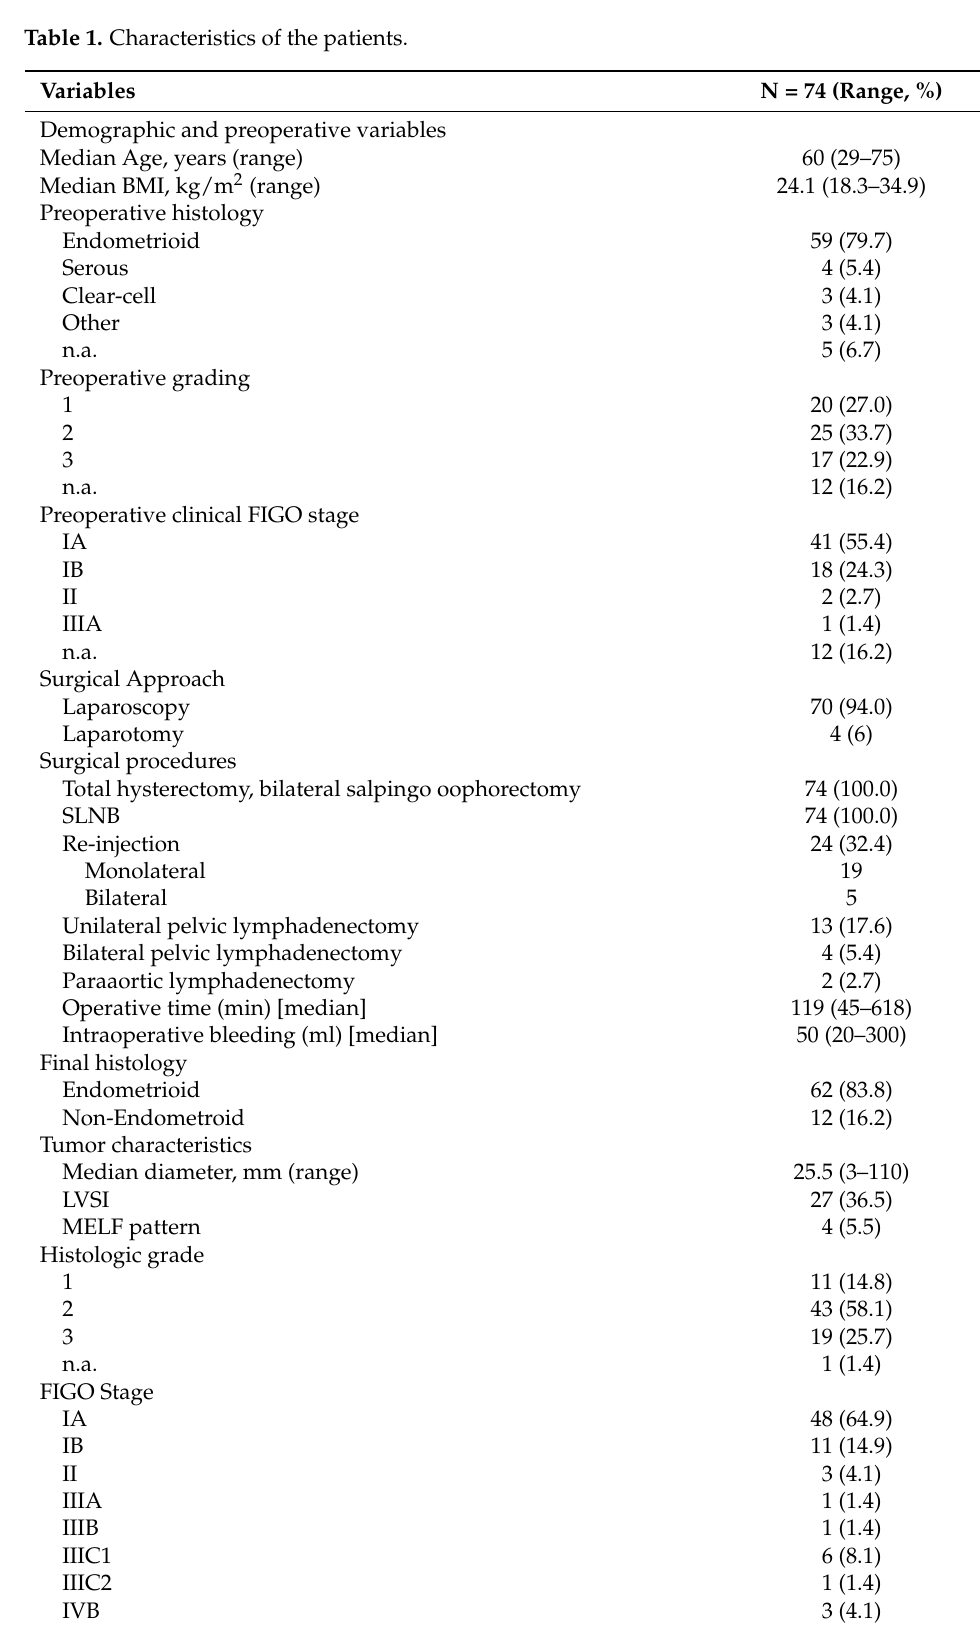
Table 1. Characteristics of the